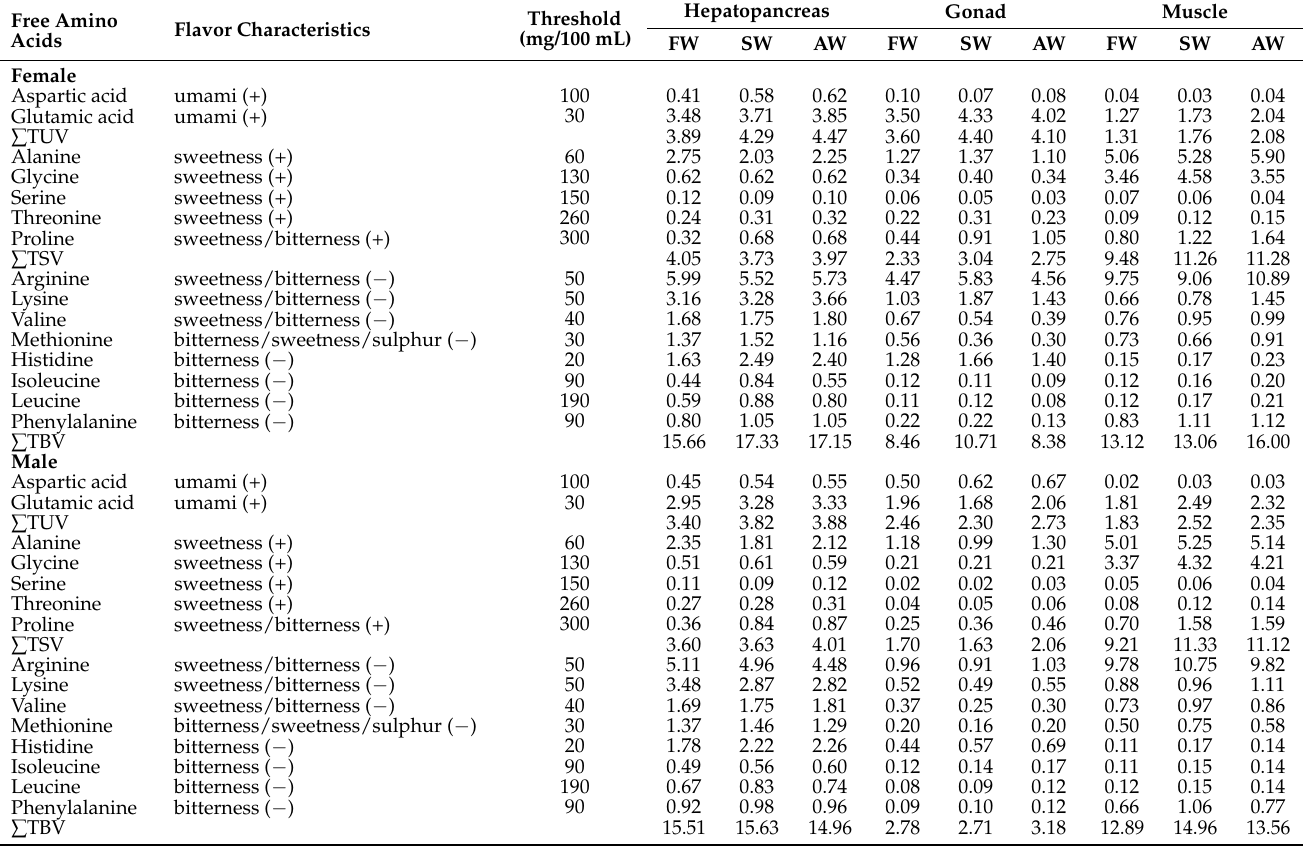
Table 4. The threshold and taste activity value of free amino acid composition in hepatopancreas, gonad, and muscle of adult Eriocheir sinensis fattening in different culture